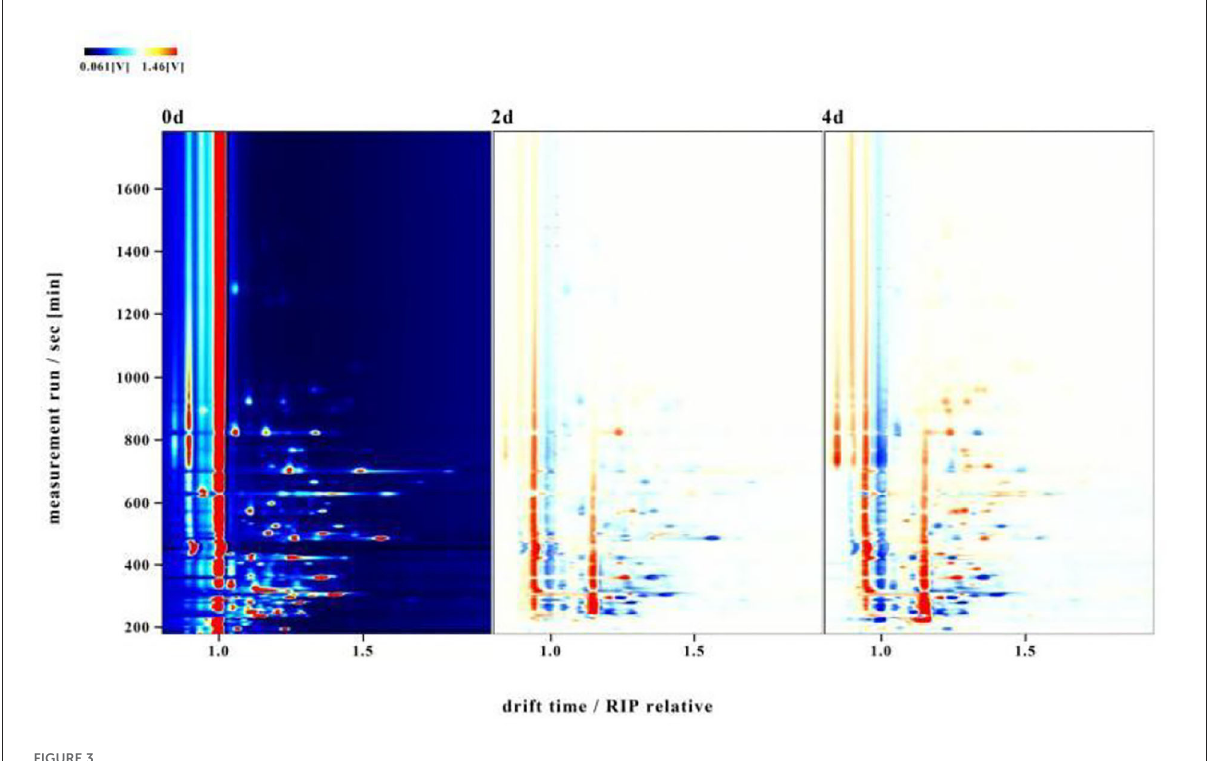
FIGURE3 Two-dimensional (2D) spectra of